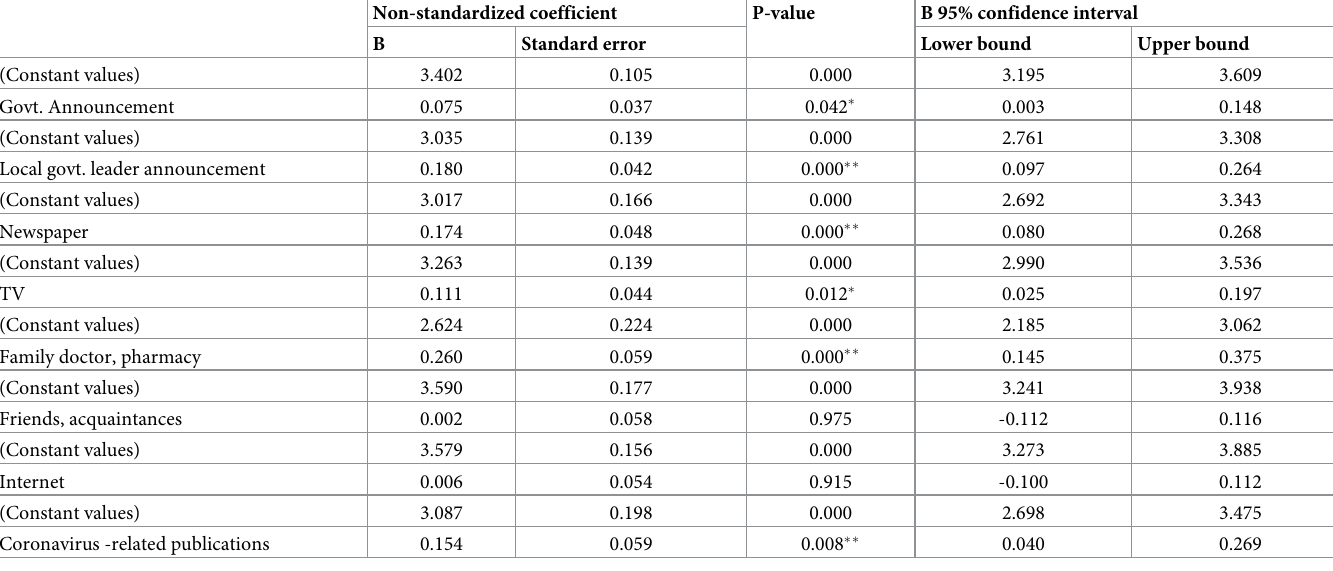
Table 10. Univariate linear regression analysis of willingness to undergo vaccination and information source